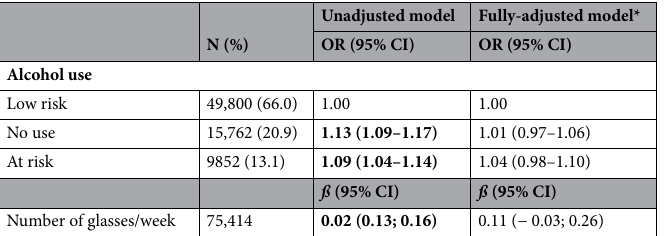
Table 4. Association between high physical exertion at work and alcohol use at 1-year of follow-up among employees in the CONSTANCES cohort study, 2012–2018 (odds ratios (ORs), and 95% confidence intervals, CI). Alcohol use was defined as: low risk (1–27 drinks/week in men and 1–13 in women); no use and at risk (≥ 28 drinks/week in men and ≥ 14 in women). Significance values are given in bold. *Adjusted for age (years, continuous), sex, occupational grade (low; medium; high), depressive symptoms at baseline (no; yes), educational level (levels, continuous), household income (€/month, continuous) and baseline level of consumption.